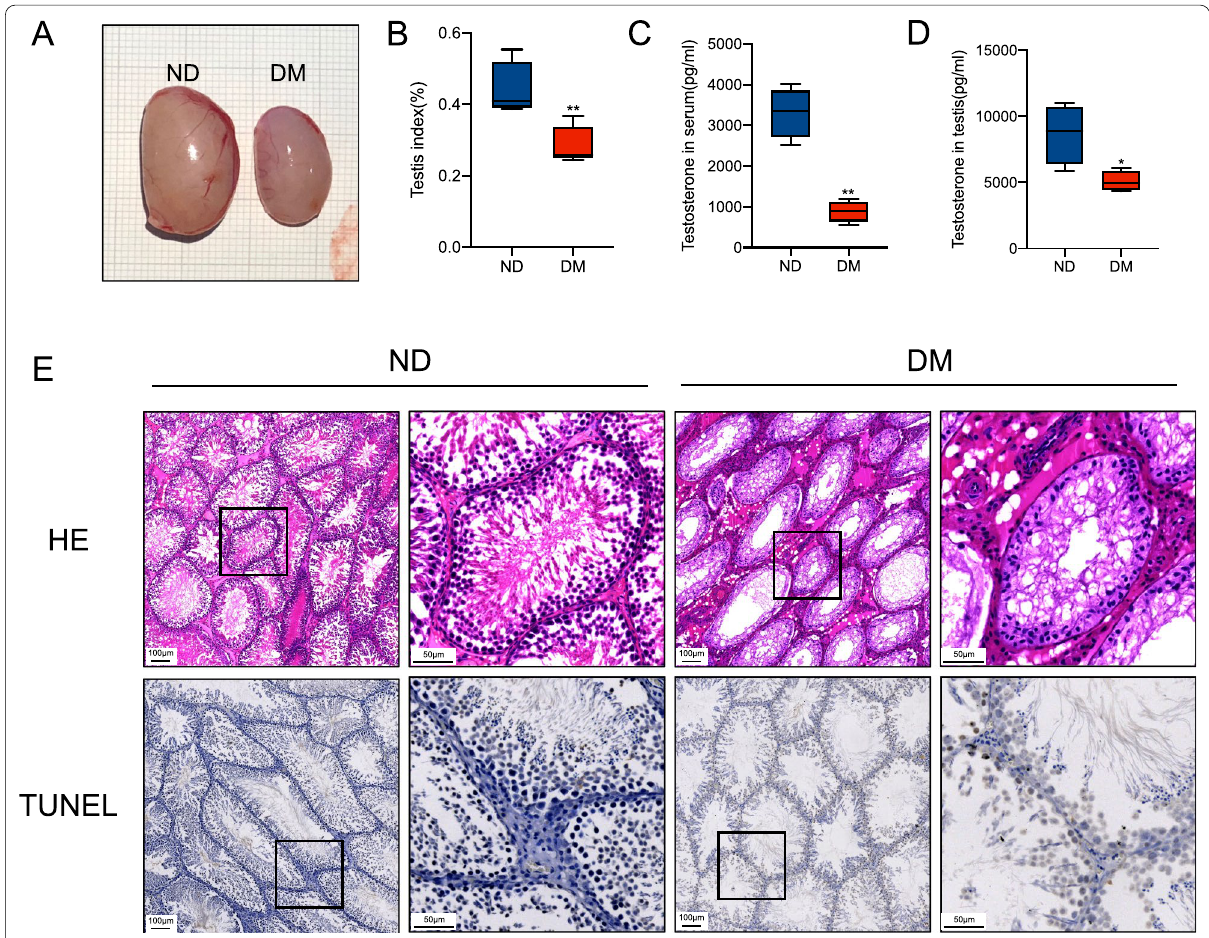
Fig. 1 Effects of diabetes on testicular function and apoptosis. Eight weeks after diabetes was established, the right testis of each rat was removed and separately photographed ( A ) and the testis index {(testis weight/body weight) 100%} was calculated ( B ). Concentrations of serum ( C ) and × testicular ( D ) testosterone detected by ELISA in each group. Representative hematoxylin & eosin (H&E) and TUNEL staining of rat testicular tissues from ND (first 2 panels) and DM (last 2 panels) groups. For a better comparison, the second panel in each group is a partially enlarged panel (black box) of the first panel. Scale bar 100 μm (first panel) and 40 μm (second panel) ( E ). Data are presented as mean SD.*p < 0.05 **p < 0.01 compared = ± with the ND